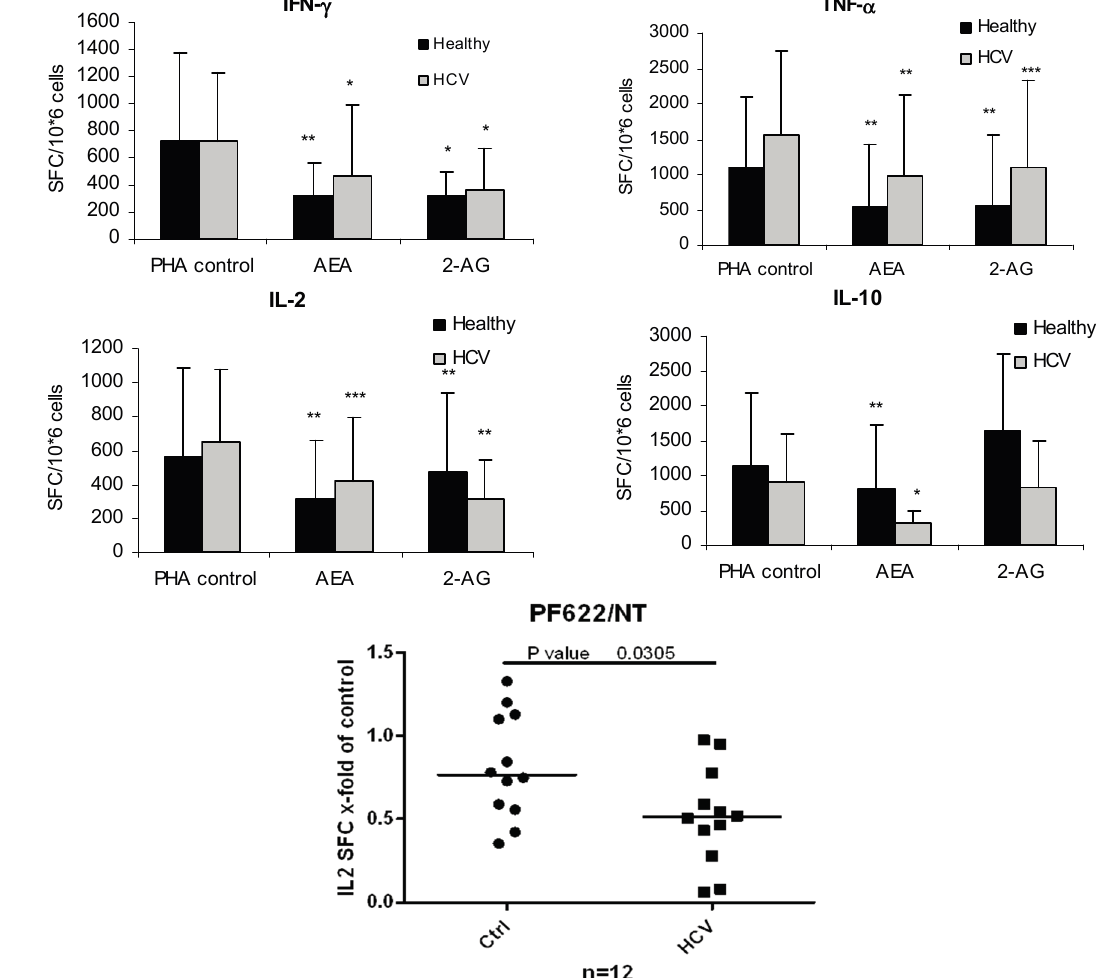
Figure 4. Inflammatory cytokines expression after EC treatment in PBMC. IFN- γ , TNF- α , IL-2 and IL-10 mRNA ( A ) and protein secretion ( B ) in phytohaemagglutinin (PHA)-stimulated PBMC isolated from healthy controls and HCV patients ( n ≥ 10 each group); ( C ) IL-2 production after FAAH inhibition with PF-622 (1 µM). Results are expressed as arbitrary units or spot-forming cells (SFC) per 1 × 10 6 cells. * p < 0.05; ** p < 0.005; *** p < 0.0005 vs . corresponding